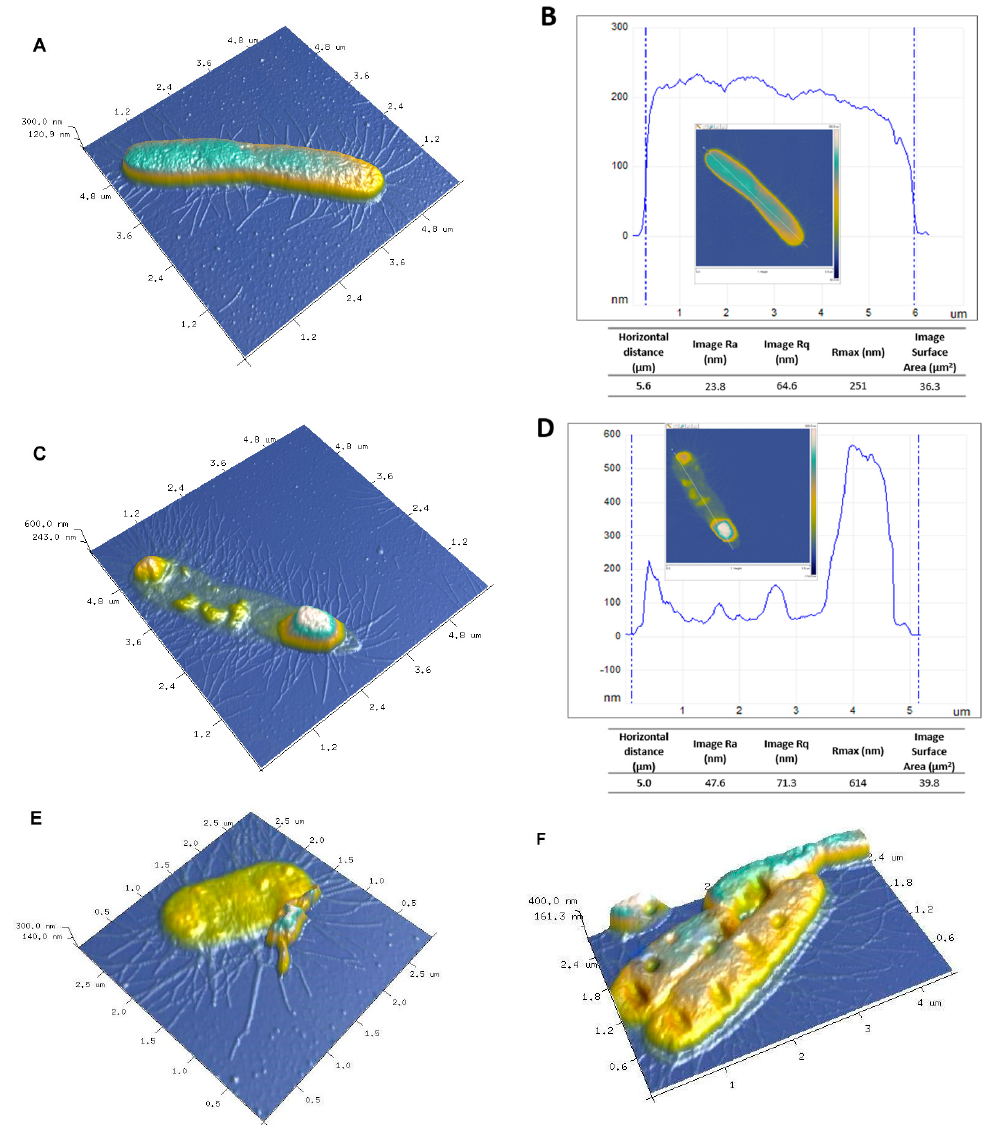
Figure 14. AFM images of E. coli untreated (control sample) and E. coli exposed to silver nanoparticles in BP/AgP, ( A ) topography as 3D view and ( B ) cross-section according to a selected line of the untreated sample, ( C , E , F ) AFM 3D visualization of the E. coli after exposure to BP/AgP and ( D ) cross-section according to a selected line of the treated bacteria presented in image ( C ) Tables include the roughness parameters for evaluating average surface roughness and morphological changes (Ra—roughness average defined as the arithmetic mean of the absolute values of the height of the surface profile, Rq—root mean square roughness, which is similar to the roughness average, however, include the mean squared absolute values of surface roughness profile; Rmax—the maximum profile peak height from the baseline, image surface area—a total area defined also for grains and masked